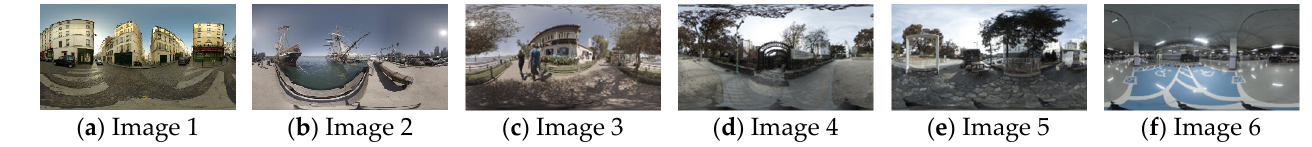
Figure 17. Test images: six equirectangular images where the horizontal and vertical FOVs are 360° × 180°, respectively.